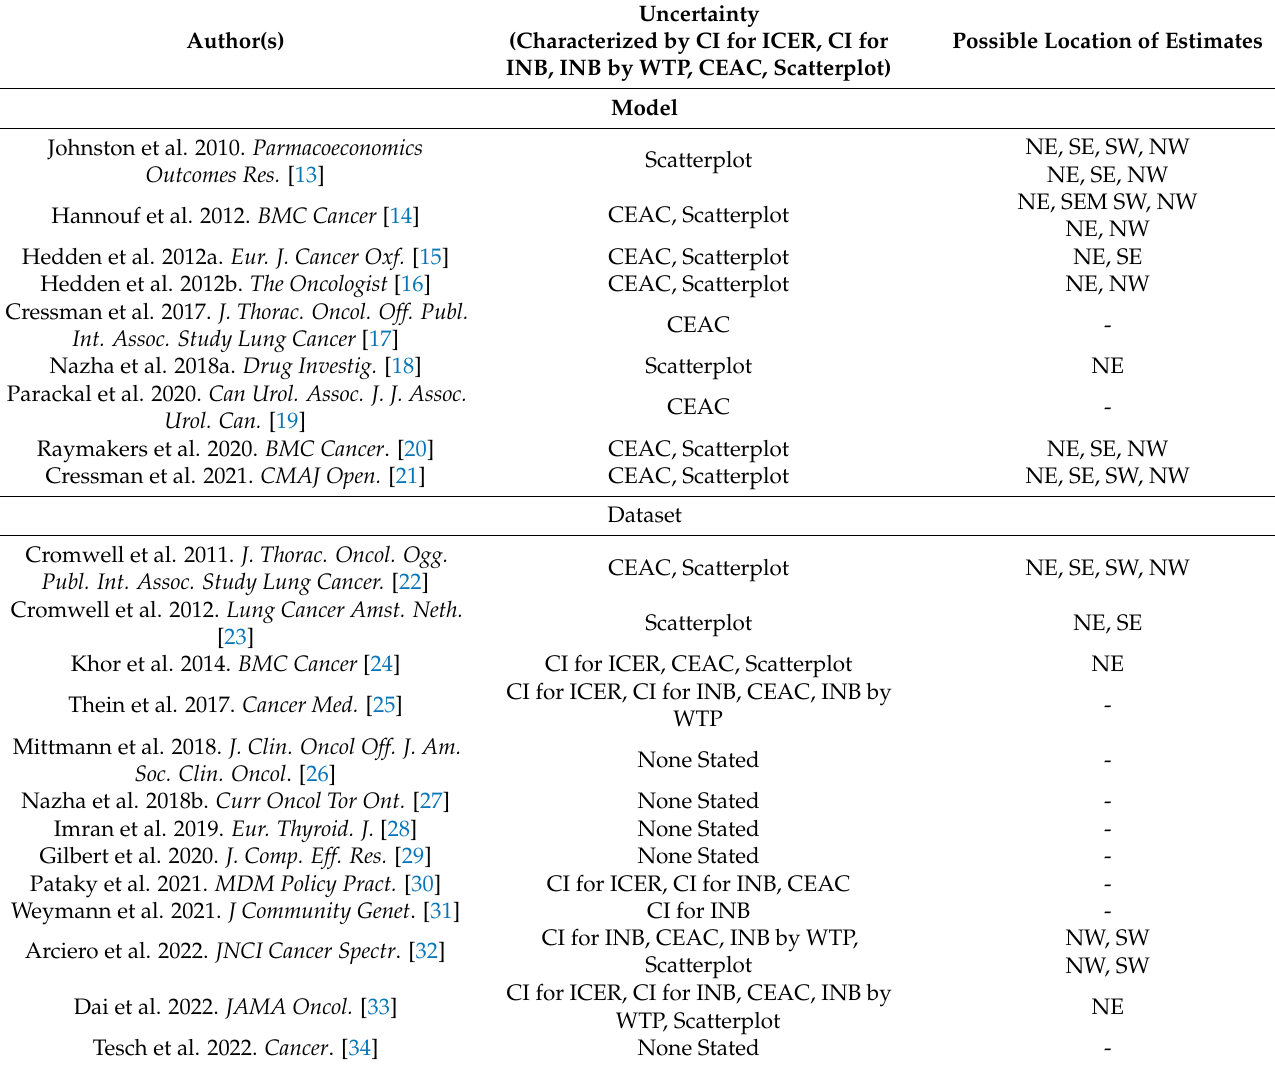
Table 2. Summary of selected article interventions and